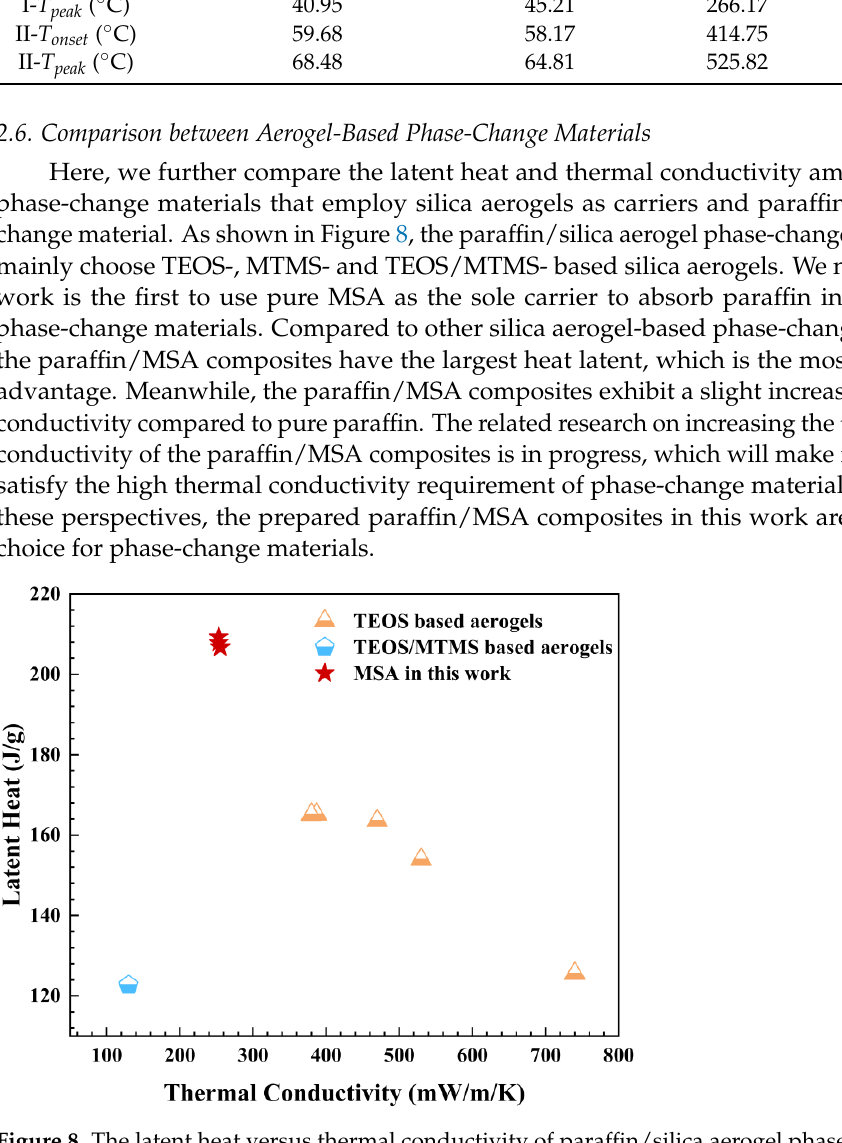
Figure 8. The latent heat versus thermal conductivity of paraffin/silica aerogel phase-change com- posite materials in this work, including TEOS-based aerogels [30,32,47], TEOS-/MTMS-based aero- gels [48] and MSA.